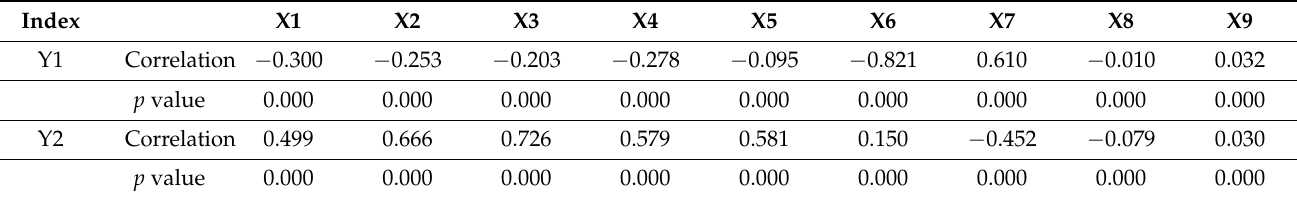
Table 13. Correlation analysis of 9 driving forces of EEC and